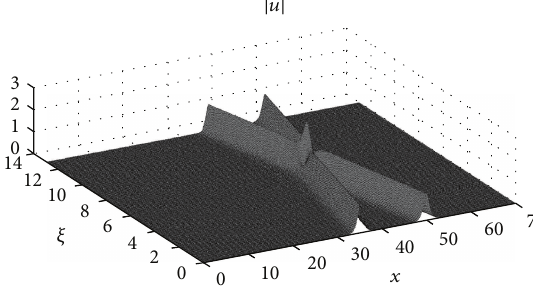
Figure 11: Collision of coupled-mode solitons with 𝜙 1 = 𝜙 2 = 0 . Figure 12: Collision of coupled-mode solitons with 𝜙 1 = 𝜙 2 = 0